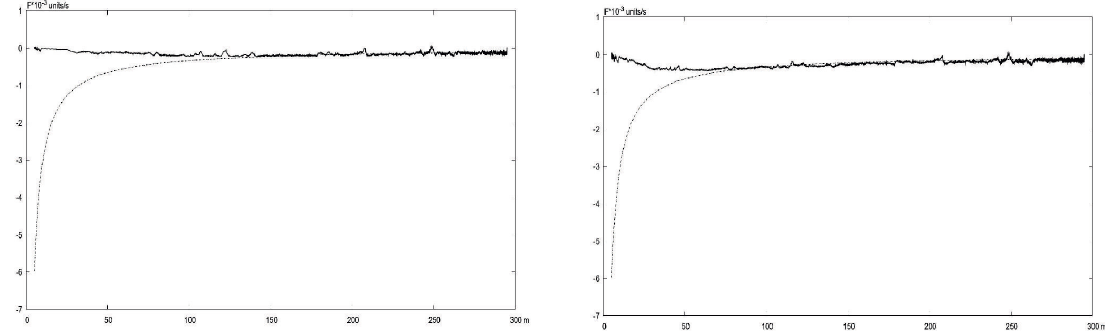
Figure 12. Optical flow velocities via Lucas-Kanade (bold) in comparison with exact values (dots) calculated for different level of scaling: left – 4 × 4, right –8 × 8.